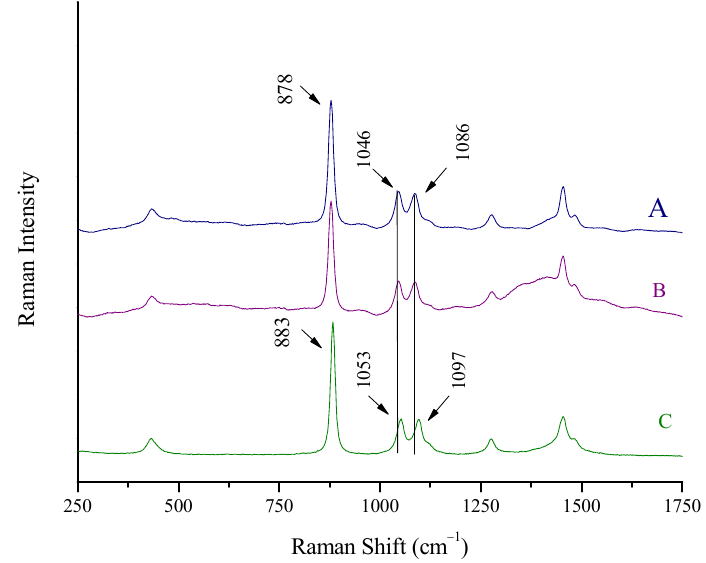
Figure 2. Raman spectra of (A) a spirit (whiskey, 43% vol) recorded using a Raman cuvette, (B) the same spirit using the Raman portable system and the “through the container” method, and (C) pure ethanol. Major ethanol peaks at 883, 1053, and 1097 cm −1 shifted to 878, 1046, and 1086 cm −1 for the whiskey.